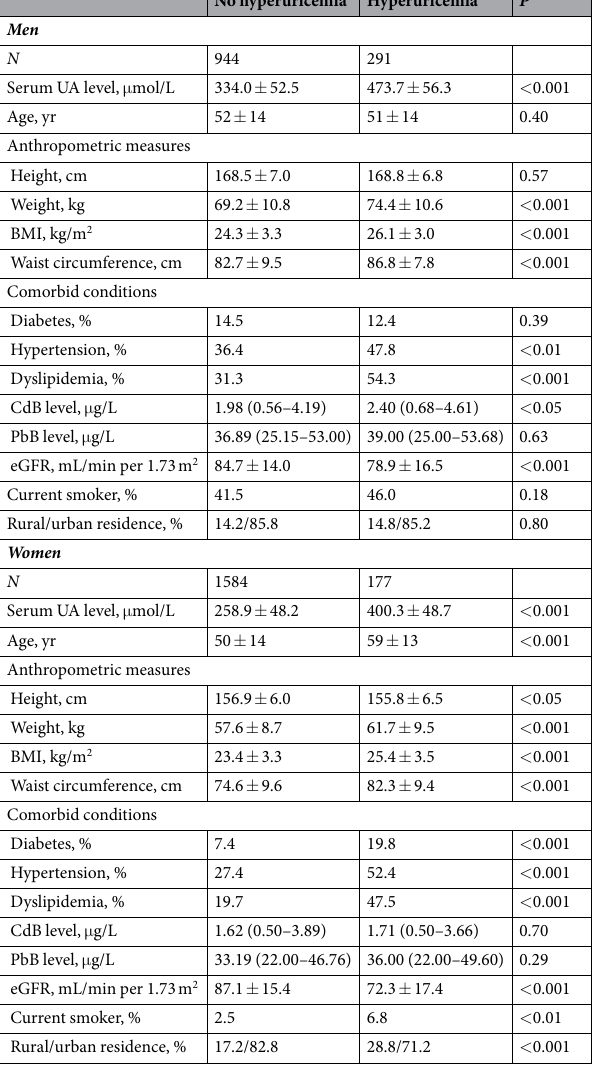
Table 1. Characteristics of the participants categorized by hyperuricemia status. Data are summarized as the mean ± SD or median (interquartile range) for continuous variables or as a number with a proportion for categorical variables. Dyslipidemia was defined as total cholesterol ≥ 6.22 mmol/L, triglycerides ≥ 2.26